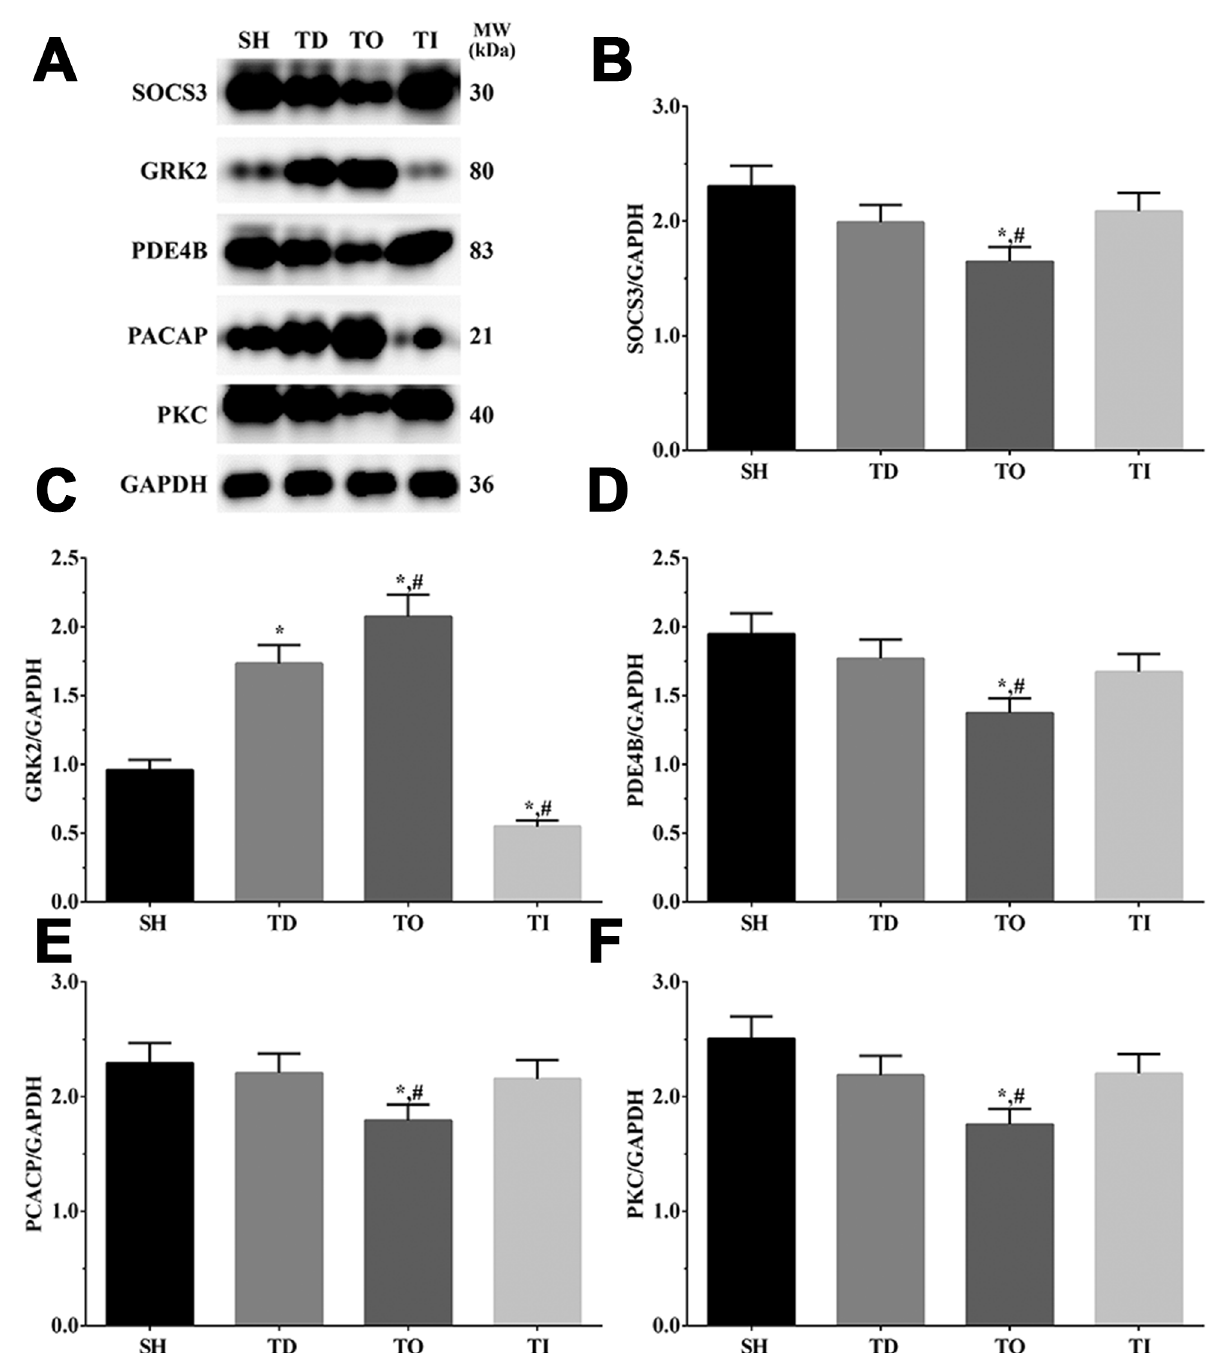
Figure 6 – Detection of neuron protective factors in brain tissue of rats. (A) Western blotting analysis of SOCS3, GRK2, PDE4B, PCACP and PKC in glial cells. (B-F) Quantitative analysis of each target protein. Data was presented as mean ± SD, each experiment was repeated for three times. *P<0.05 vs SH group of rats. #P<0.05 vs signal dezocine treatment group. NC: normal group, DT: dezocine treatment group, DO: dezocine treatment combined with RAPGEF3 overexpression group, DI: dezocine treatment combined with RAPGEF3 inhibition group. SH: sham group, TD: dezocine treatment group, TO: dezocine treatment combined with RAPGEF3 overexpression group, TI: dezocine treatment combined with RAPGEF3 inhibition